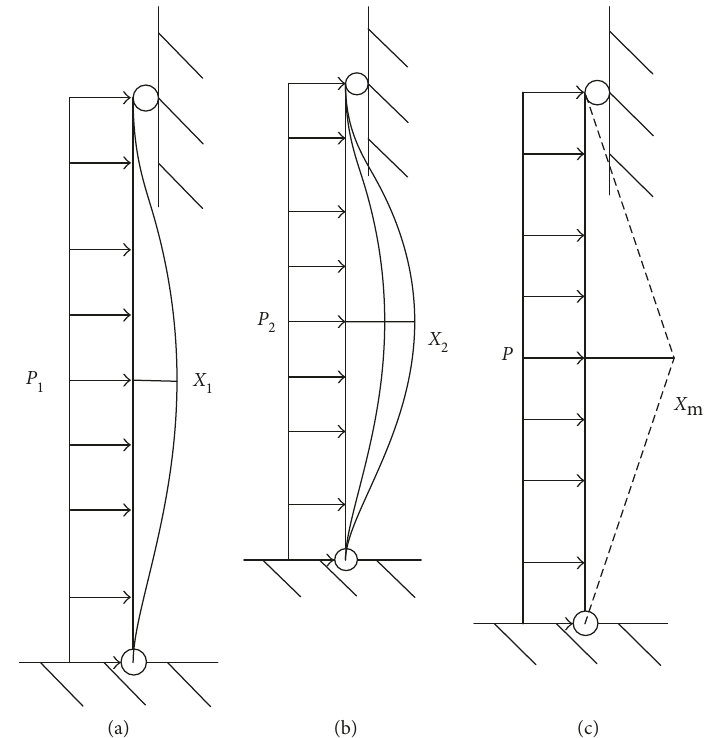
Figure 3: The simplified rigid plastic model of the RC pier: (a) plastic hinge at the bottom of the pier; (b) plastic hinge at the bottom and midheight of the pier; (c) simplified rigid plastic